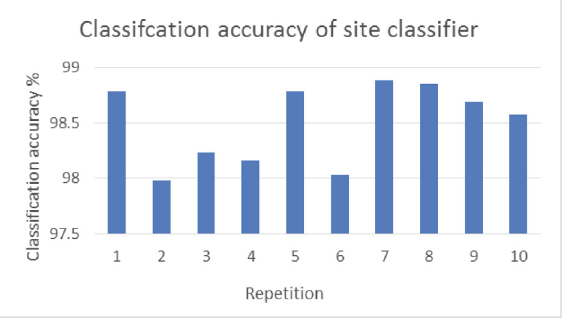
Fig 3. Classification accuracy of site classifier for each repetition, where a 10-fold cross-validation was